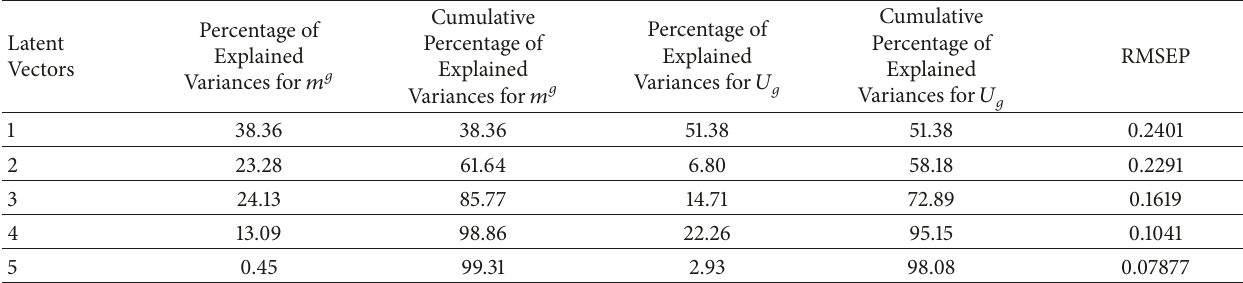
Table 9: Variance of 𝑚 𝑔 and 𝑈 𝑔 explained by the latent vectors and RMSEP for Indonesia.